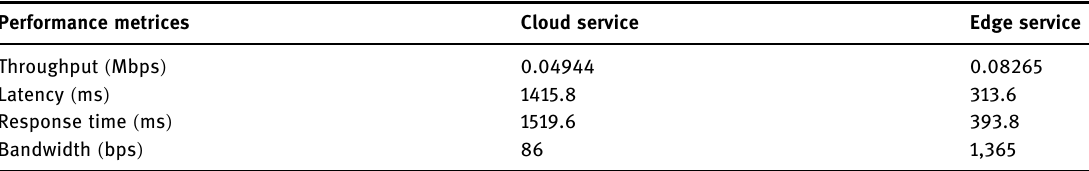
Table 6: Performance metrices for cloud and edge